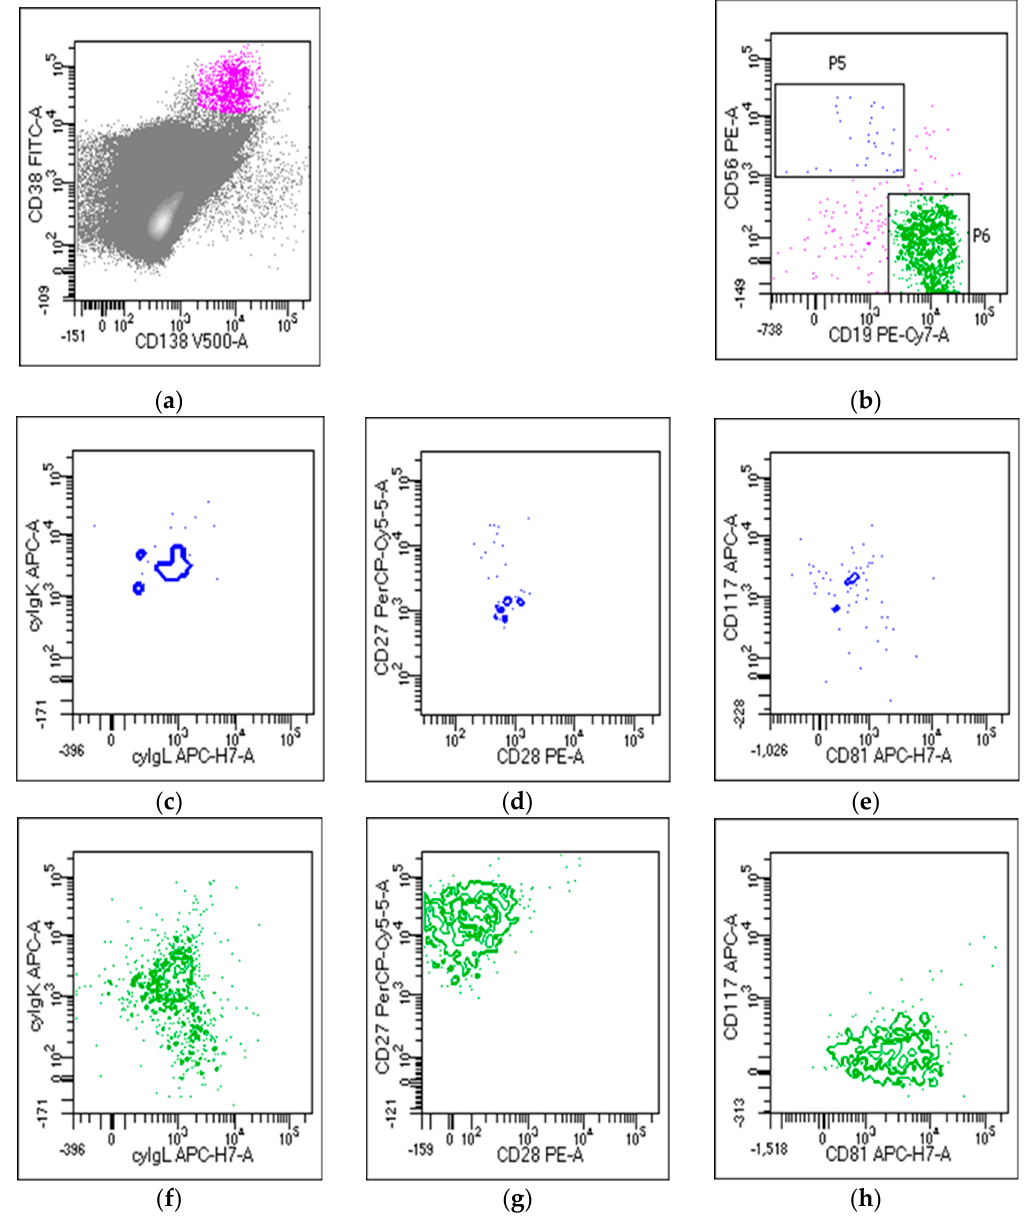
Figure 1. Minimal residual disease (MRD) detection by flow cytometry. ( a ) Plasma cell identification using CD38 and CD138 combination; ( b ) very little amount of abnormal plasma cells expressing CD56 (P5), and large amount of normal plasma cells expressing CD19 (P6) were detected; abnormal plasma cells expressing ( c ) only k light chain, and ( d ) CD28 and ( e ) CD117 antigens; normal plasma cells expressing ( f ) both k and l light chains, and ( g ) CD27 and ( h ) CD81 antigens.